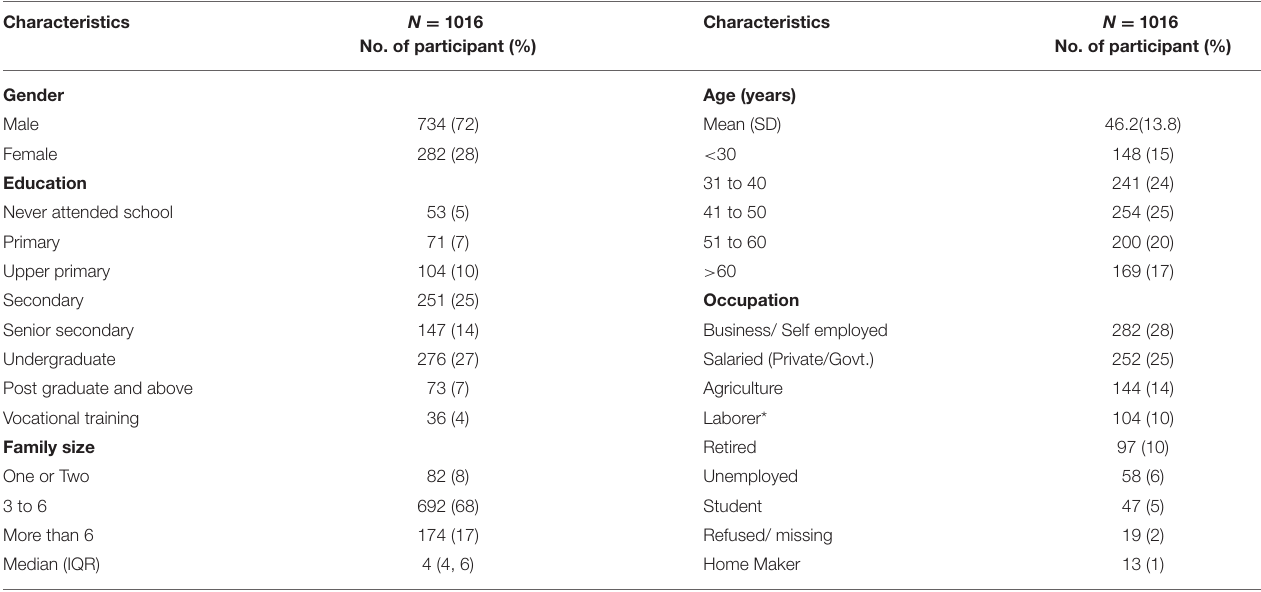
TABLE 2 | Socio demographic characteristics of the study participants.